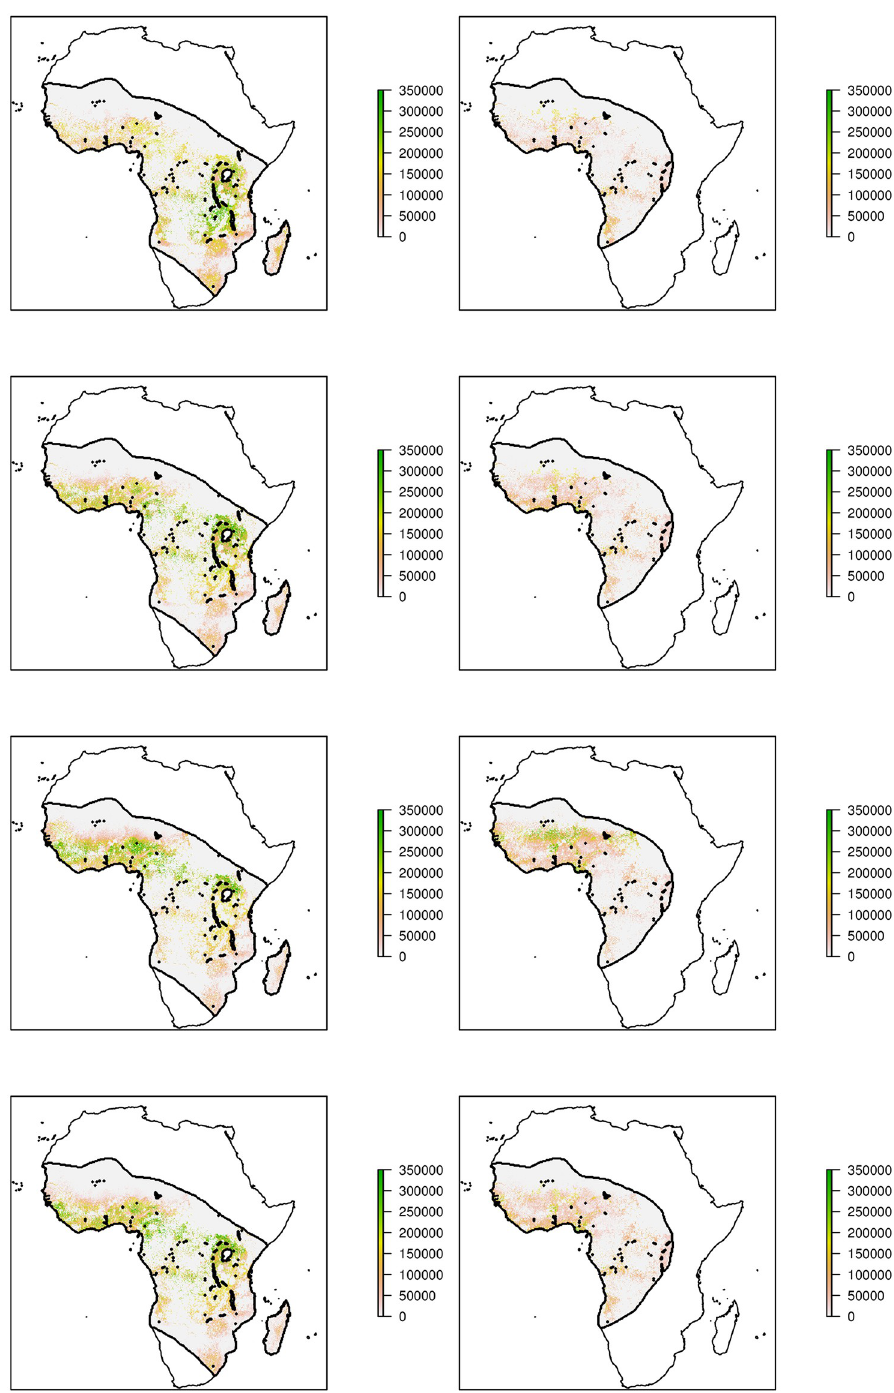
Fig 3. Estimated larval carrying capacity of An. gambiae s.s. (left) and An. coluzzii (right), for 2005 (the first year of modelling) in January (Southern Hemisphere summer), April (autumn), July (winter) and October (spring) from top to bottom. Base map from Natural Earth: https://www.naturalearthdata.com/downloads/10m-physical-vectors/10m- coastline/.